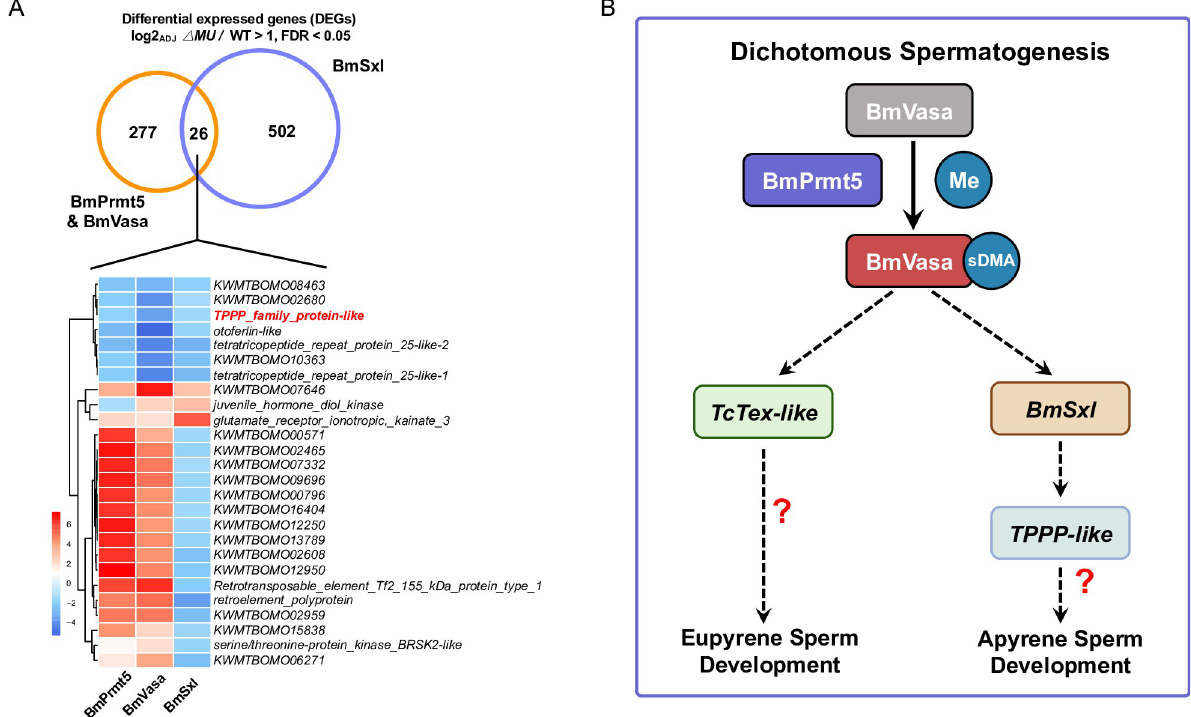
Fig 7. Proposed model for the functions of the BmPrmt5–BmVasa module in B . mori . (A) Upper: Venn diagram of numbers of sperm-specific genes commonly and specifically regulated by BmSxl (right, purple) and BmPrmt5–BmVasa module (left, orange) relative to WT. Lower: Hierarchical clustering analysis of genes regulated by BmPrmt5, BmVasa, and BmSxl. The fold change of each gene in different samples is shown in the heatmap (blue, down-regulated; red, up-regulated). (B) Model illustrating how the BmPrmt5–BmVasa module may regulate dichotomous spermatogenesis in B . mori . BmPrmt5 catalyzes the sDMA of residues in BmVasa. As a result, BmVasa enhances the expression of spermatogenesis- related genes such as BmSxl , BmTPPP-like , and BmTctex-like to promote eupyrene and apyrene sperm